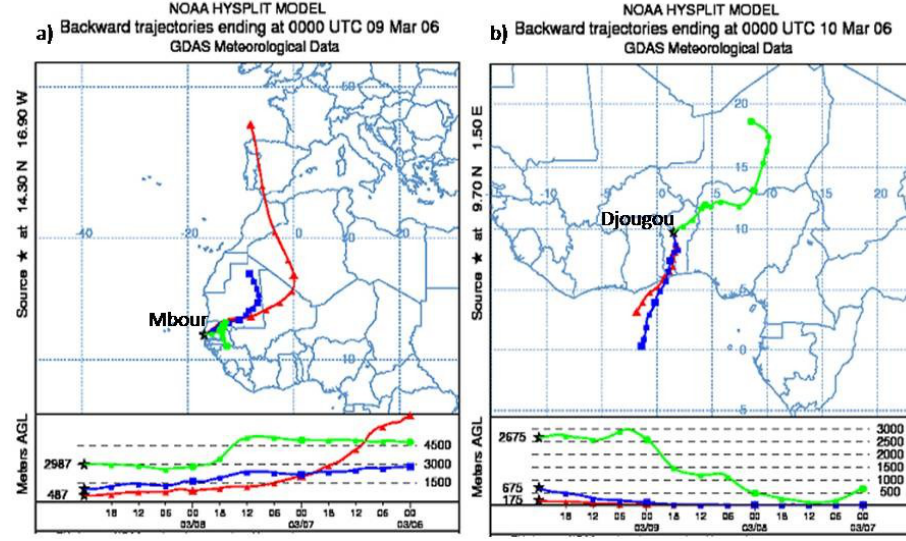
Fig. 14. NOAA Hysplit Model, backward trajectories at the 500m level (red line), 1000mlevel (blue line) and 3000m level (green line) ending at: (a) 00:00 UTC, 9 March 2006, over Mbour and (b) 00:00 UTC, 10 March 2006, over Djougou.